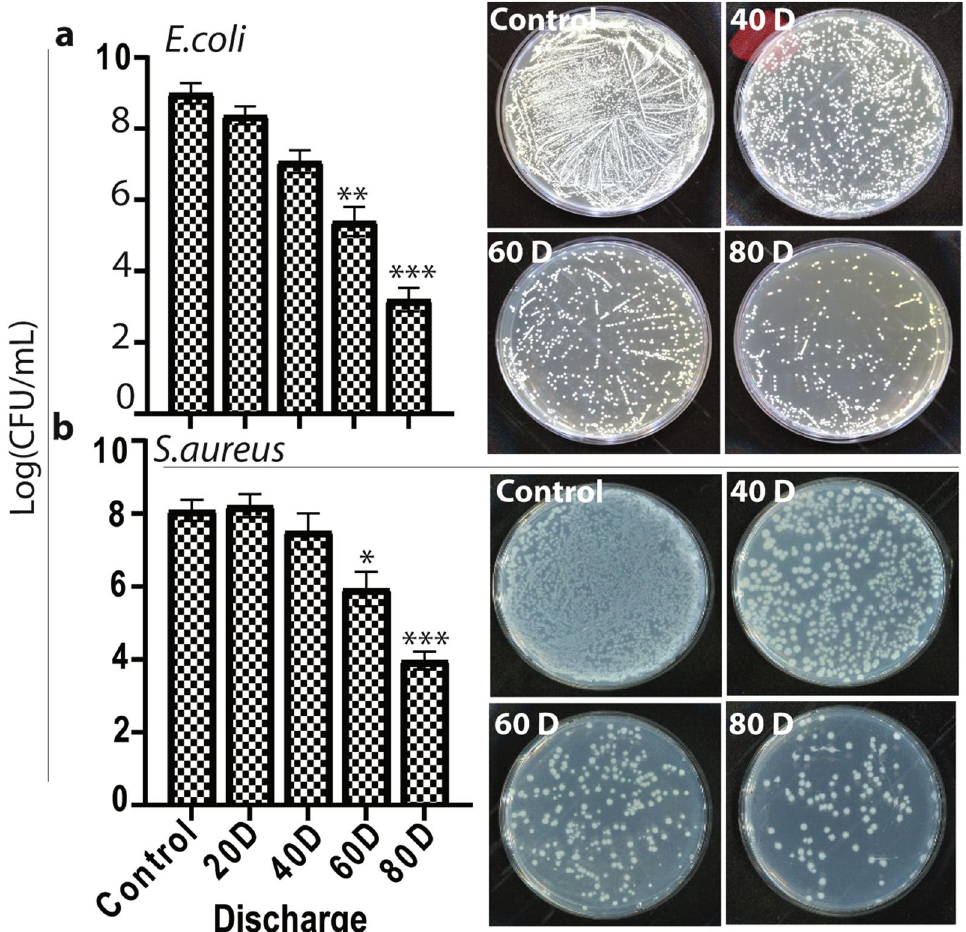
Figure 5. Inactivation of ( a ) E. coli and ( b ) S. aureus bacterial strains after various doses of microwave radiation. All values are expressed as mean ± SD in triplicate. Student’s t-test was performed for the statistical analysis (* P < 0.05, ** P < 0.01, and *** P <